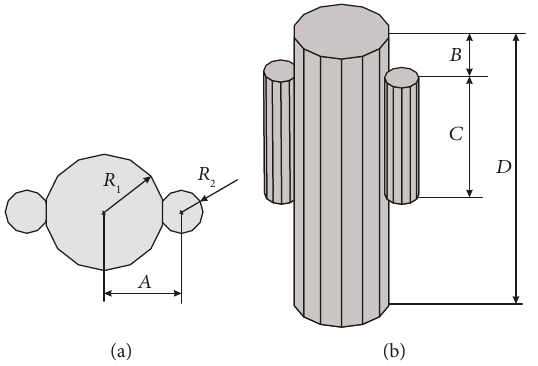
Figure 10: Geometry of the simpli fi ed human body model: (a) top view; (b) side view.